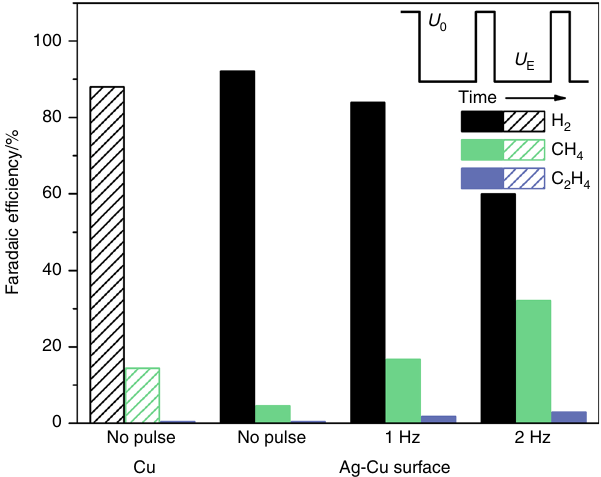
Fig. 6 Faradaic ef fi ciencies of major carbon monoxide electroreduction products. Constant potential electrolysis at − 1.1 V RHE is conducted on the bare Cu and Ag-Cu surfaces. Square-wave potential electrolysis alternating between 0.4 V RHE ( U 0 ) and − 1.1 V RHE ( U E ) is conducted on the Ag-Cu surface. Inset: schematic representation of the square-wave potential pro fi le employed in the